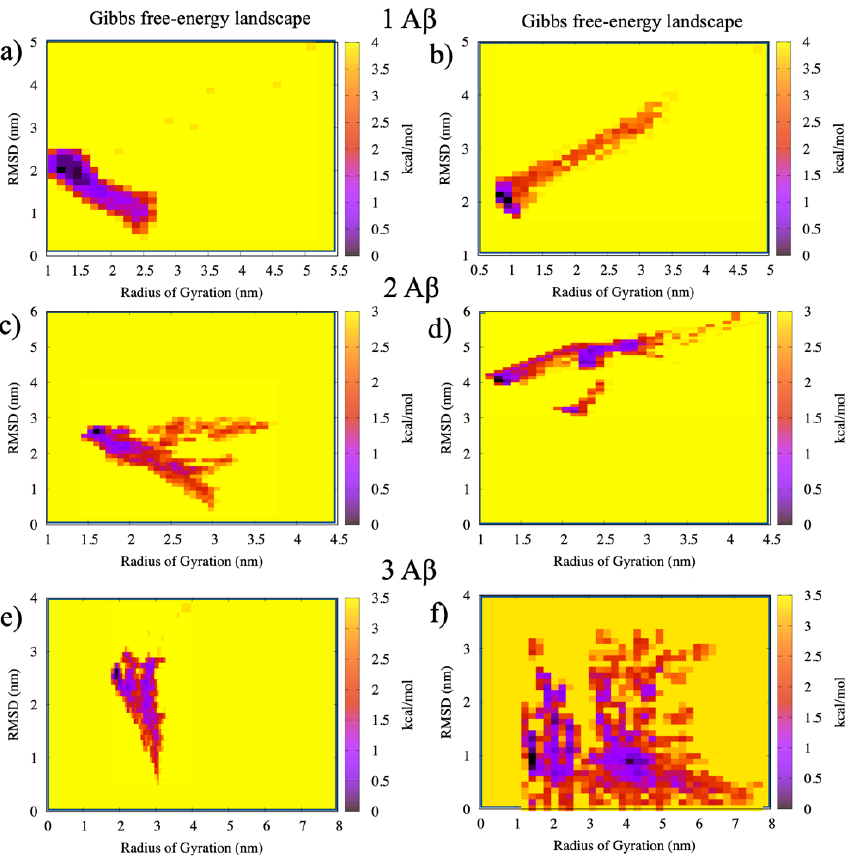
Figure 6. Free-energy surfaces (FES) of the A β monomers: in panels ( a , b ), the single monomer, in panels ( c , d ), the two monomers, and in panels ( e , f ), the three monomers without (left panels) and with (right panels) AuNP, respectively. RMSD: root mean square displacement.